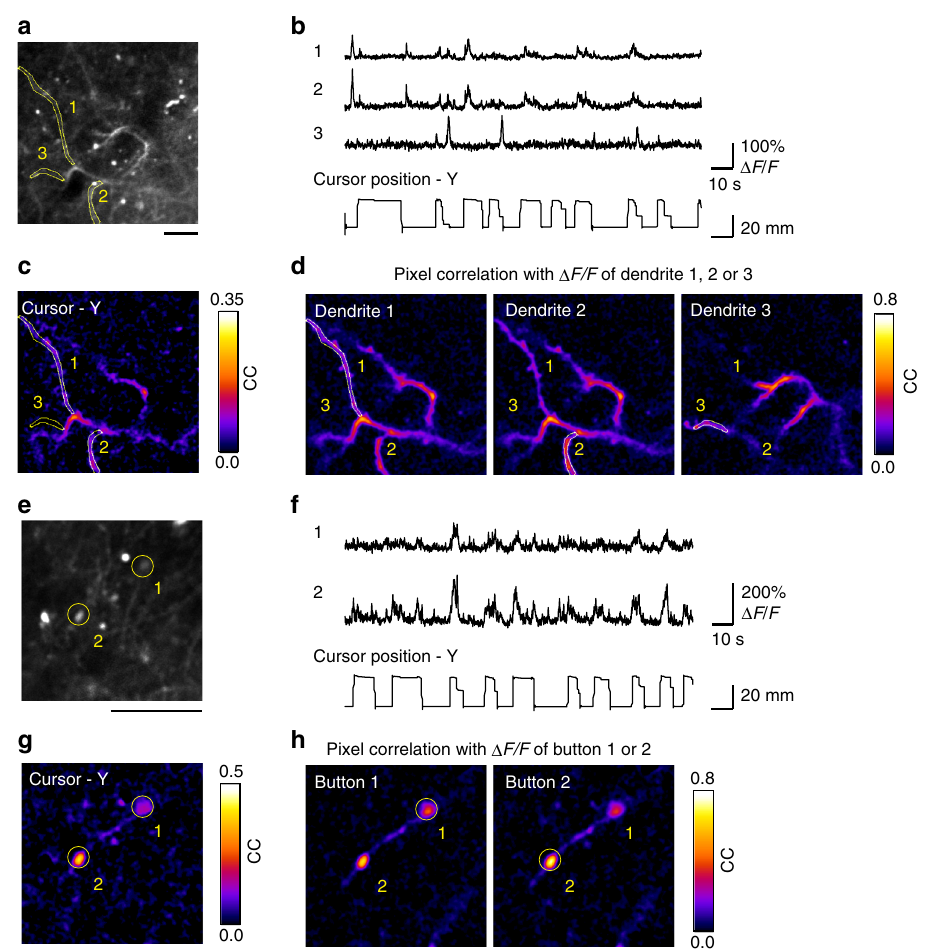
Fig. 9 Two-photon imaging of subcellular activity in layer 1 of the M1 during the task. a Representative time-averaged two-photon image of dendritic compartments at a depth of 51 μ m from the cortical surface in the M1 of marmoset D. Scale bar, 30 μ m. b Motion-corrected Δ F / F traces of three representative dendritic compartments indicated by the numbers in a . The Y-axis trajectory of the pole is shown at the bottom. c Map of correlation coef fi cients between the Y-axis cursor trajectory and the Δ F / F trace in each pixel. d Map of correlation coef fi cients in the Δ F / F traces with ROI 1 (left), ROI 2 (middle), and ROI 3 (right). e Representative time-averaged two-photon image of axonal buttons at a depth of 46 μ m in the M1 of marmoset D. Scale bar, 20 μ m. Other conventions are the same as in a . f Motion-corrected Δ F / F traces of two representative axonal buttons indicated by the numbers in e . g Map of correlation coef fi cients between the Y-axis cursor trajectory and the Δ F / F trace in each pixel. h Maps of correlation coef fi cients for the fl uorescence changes for ROI 1 (left), and ROI 2